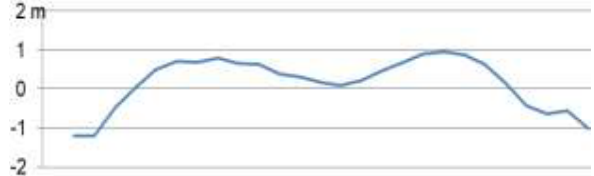
Figure 22. Systematic Z-discrepancies of Zyuan-3 DSM as function of Y; profile length = 55km, DSM